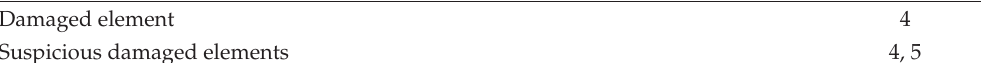
Table 2: The identified suspicious damaged